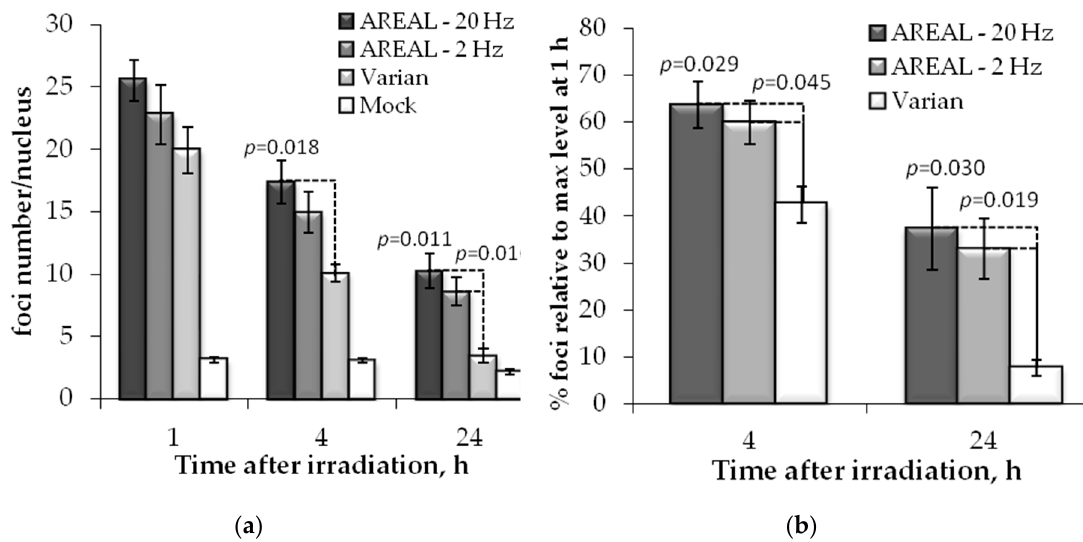
Figure 2. Post-irradiation changes of the γ H2AX foci in HeLa cells, irradiated on AREAL (ultrashort pulsed 3.6 MeV electron beams) and Varian (quasi-continuous 4.0 MeV electron beams) accelerators at a 1000 mGy dose: ( a ) number of foci in a cell nucleus; ( b ) foci % in relation to the value at 1 h post-irradiation. Mean values derived from at least three independent experiments are shown. Error bars show SE. Statistical significance was tested using the Student t -test. p values < 0.05 are shown.